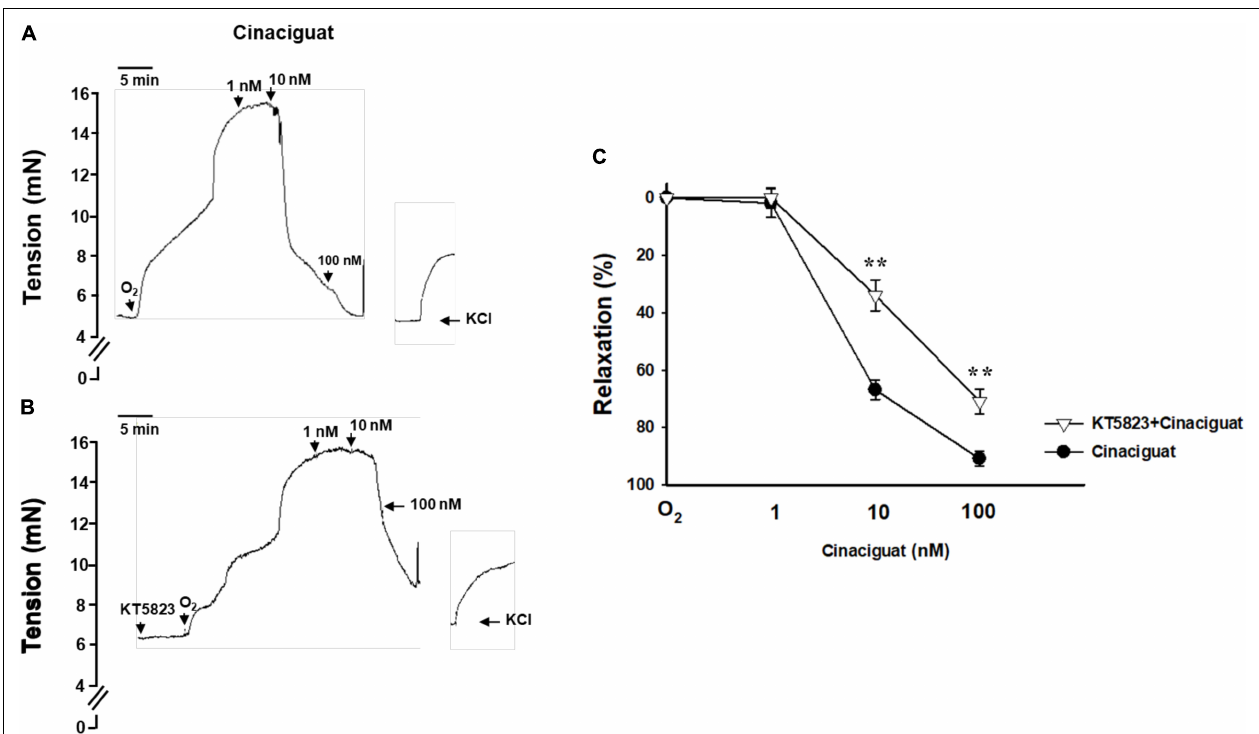
FIGURE 4 | Cinaciguat attenuated oxygen-induced ductus arteriosus (DA) constriction in the myograph study. (A) Representative force myograph traces showing isometric tension (mN) plotted against time. After DA was pre-constricted by oxygen, addition of cinaciguat caused decrement in the DA tension dose-dependently. At the end of the experiments, vasoconstriction of the DA was induced by KCl (50 mM)-containing Krebs–Henseleit solution to ascertain vessel reactivity. (B) Cinaciguat blunted oxygen-induced DA constriction dose-dependently. When pretreated with KT5823 (10 µ M), a PKG inhibitor, the vasodilatory effects of cinaciguat were attenuated at both 10 and 100 nM. (C) A comparative graph of vasodilatory effects between the two groups. Values represent the mean ± SEM; N = 4. P < 0.05 for both dose and drug effects by the repeated two-way ANOVA. ** P < 0.01 compared with the cinaciguat group by the post hoc